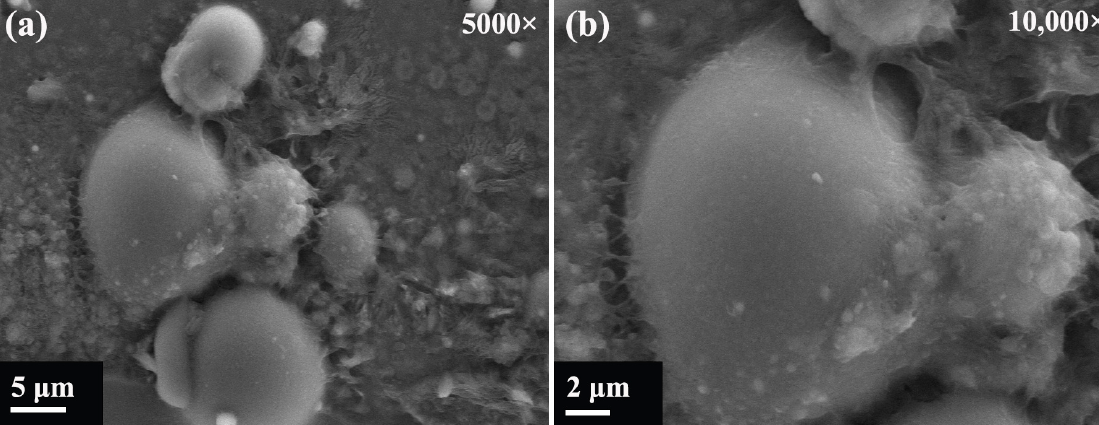
Figure 16. SEM photographs of daughter Al-Li alloy residues: ( a ) 5000×; ( b ) 10,000×.